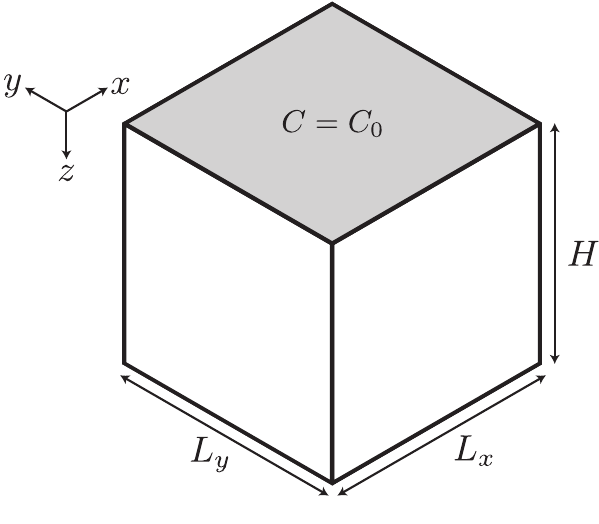
Figure 2. Schematic illustration of the three-dimensional model. The top surface ( z = 0) is initially at saturated concentration, while the remaining fluid is unsaturated. Note that z is positive